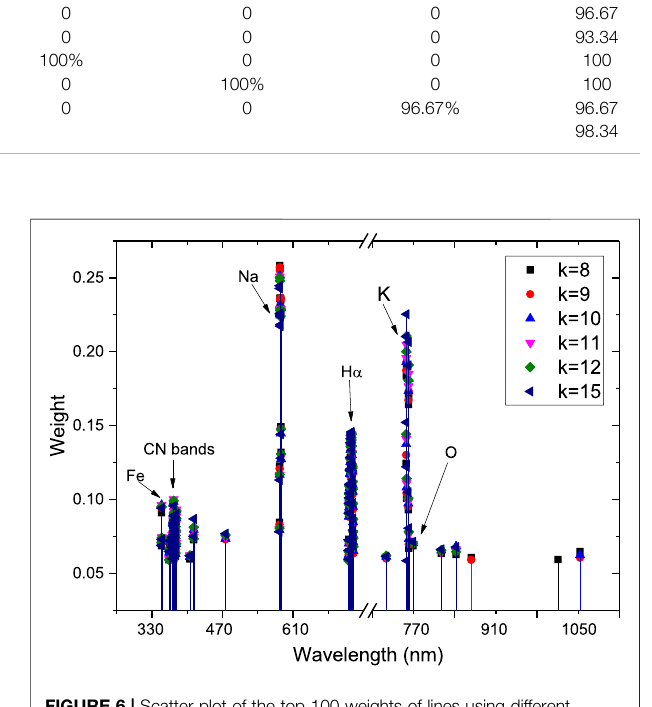
FIGURE 6 | Scatter plot of the top 100 weights of lines using different values of nearest neighbors ( k